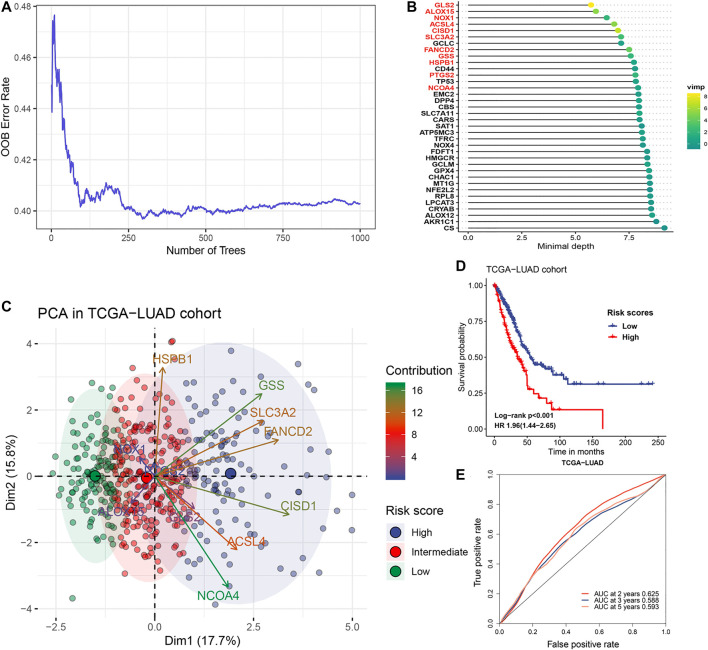
Gene selection and model construction process. (A) Estimation of the random forest OOB prediction error rate based on the number of trees. (B) The top 15 genes with the smallest minimal depth. VIMP is proportional to the size of the circle. (C) The distribution of risk scores. Gene contributions to PCA1 were annotated by gradient colors. The upper quartile and lower quartile of PCA1 were used for stratification. (D) Kaplan-Meier curves and univariate Cox regression of overall survival in the TCGA-LUAD cohort stratified by risk score. (E) ROC curve analysis for evaluating the prediction performance in the TCGA-LUAD cohort.